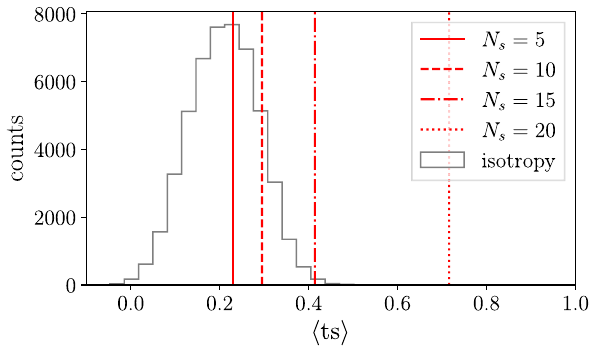
Fig. 12 Distribution of average test statistics (cid:10) ts (cid:11) iso for 5 × 10 4 isotropic skies (gray) compared with the values obtained in the bench- mark 2 simulation (vertical lines) with source densities of ρ S = 10 − 1 / Mpc 3 (blue), ρ S = 3 × 10 − 2 / Mpc 3 (orange), ρ S = 10 − 2 / Mpc 3 (green), and ρ S = 3 × 10 − 3 / Mpc 3 (red). The small triangles denote the 68% quantiles